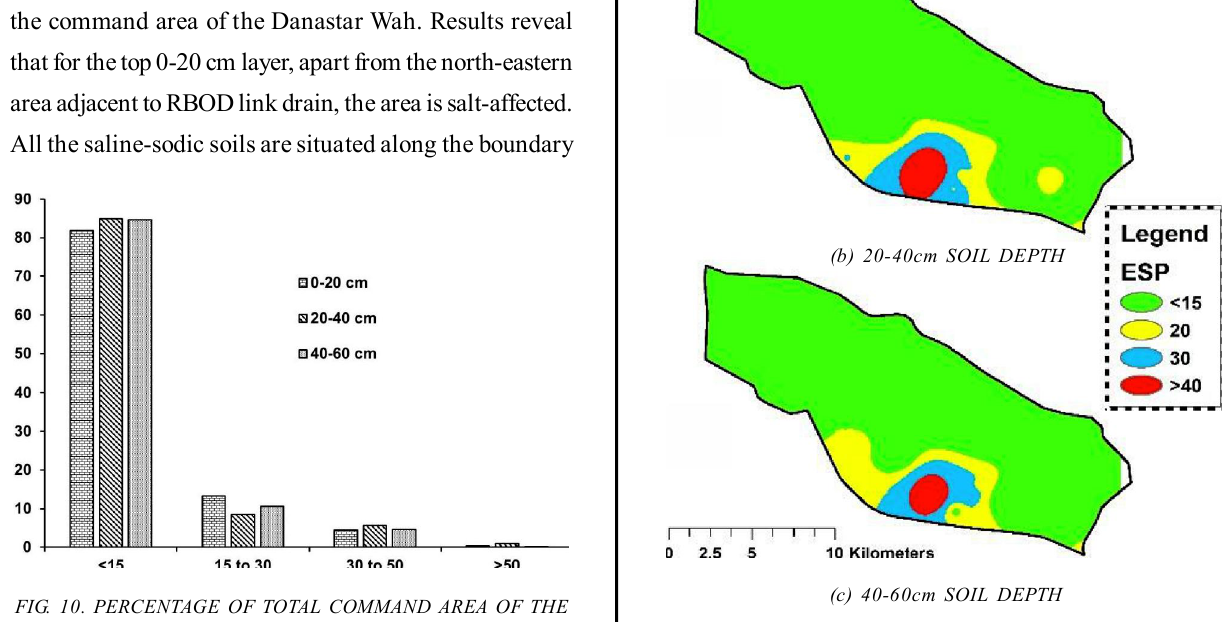
FIG. 11. SPATIAL DISTRIBUTION OF SOIL